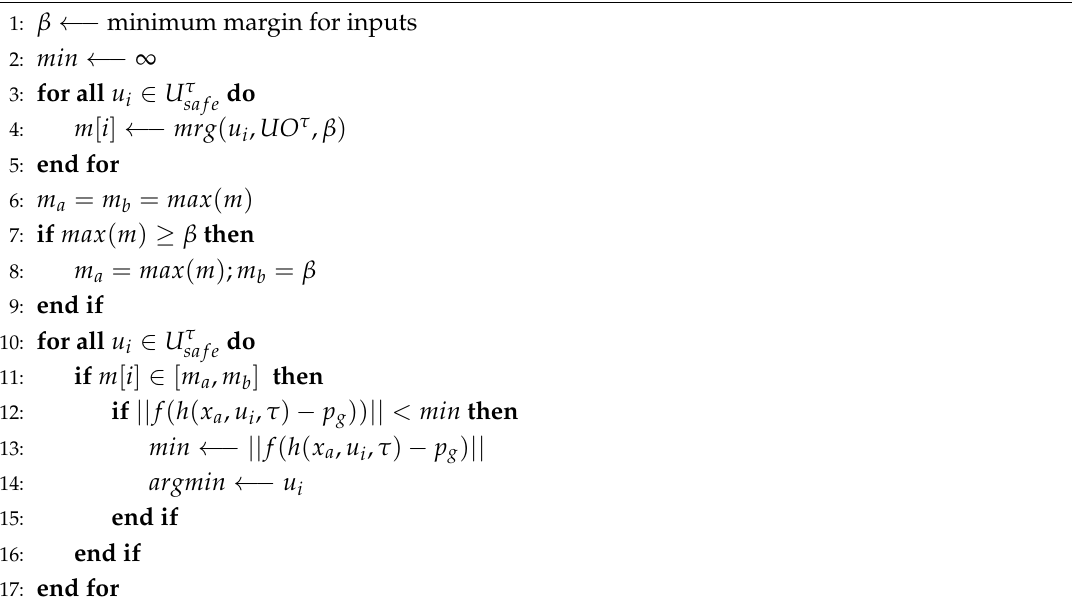
Algorithm 2 Find Best Safe Control